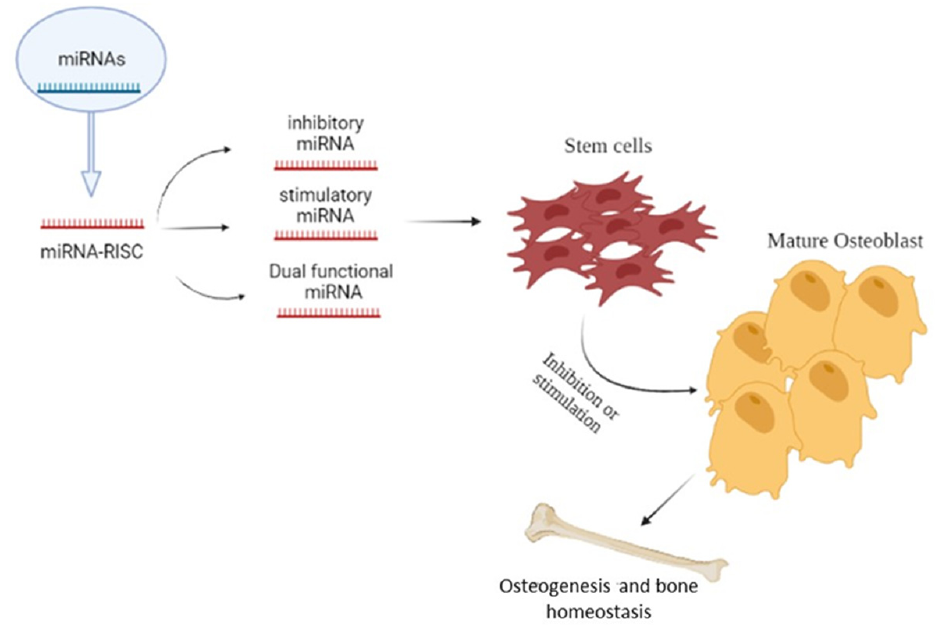
Figure 2. Role of microRNAs in osteogenesis and bone homeostasis; the Figure illustrates the possible inhibitory or stimulatory role of microRNAs in osteogenesis and bone homeostasis. In addition, chondrocytes, which are essential regulators of longitudinal bone growth, have been shown to be regulated by various miRNAs such as miR-140, a positive regu- lator of chondrogenesis that contributes to craniofacial development and endochondral bone formation through the inhibition of HDAC4 [44]. Conversely, miR-199a and miR- 145 have been shown to negatively regulate chondrocyte differentiation [45]; miR-199a downregulates the expression of SMAD1 protein [46], whereas miR-145 targets SOX9, a key transcription factor involved in chondrogenesis and cartilage formation [45,46]. Similar miRNA-based regulation has been observed during osteoblast differentiation and in bone resorbing cells. Suppression of miR-21 has been associated with upregulation of osteoclast suppressor programmed cell death protein 4 (PDCD4) and downregulation of osteoclast marker cathepsin K (CTSK), suggesting that miR-21 may be involved in bone biology both by promoting mobilization of osteoblast precursors and by regulation of osteoclast survival and differentiation